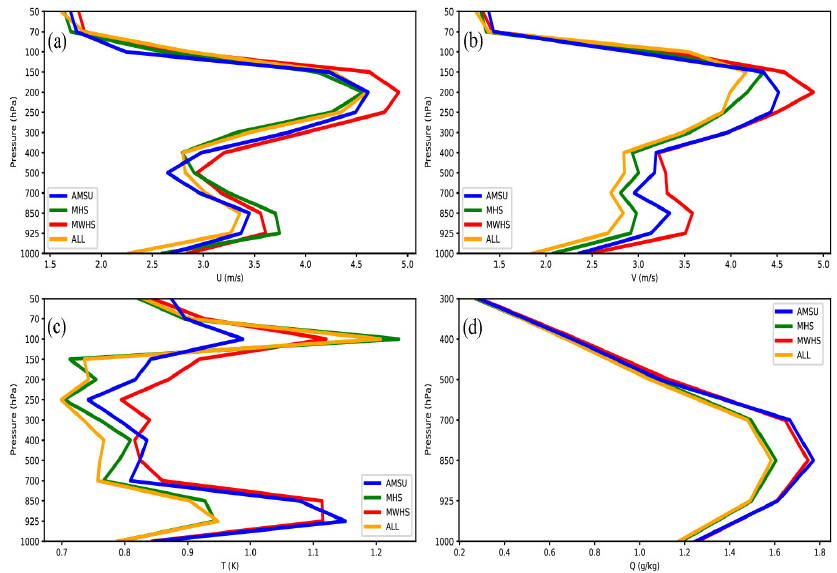
Figure 7. Vertical ( a ) U wind (m/s), ( b ) V wind (m/s), ( c ) temperature (K), ( d ) specific humidity (g/kg) RMSE profiles at 1800 UTC on 23 July 2018.